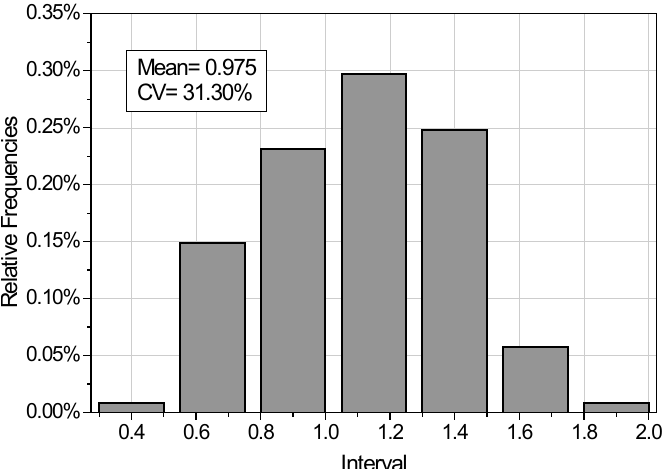
Figure 4. Histogram of the numerical simulation with Lcor =